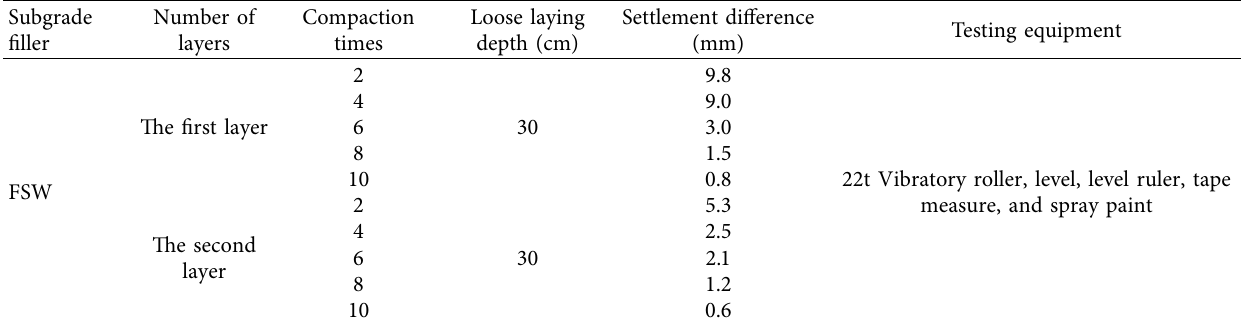
Table 8: Subgrade settlement observation index.